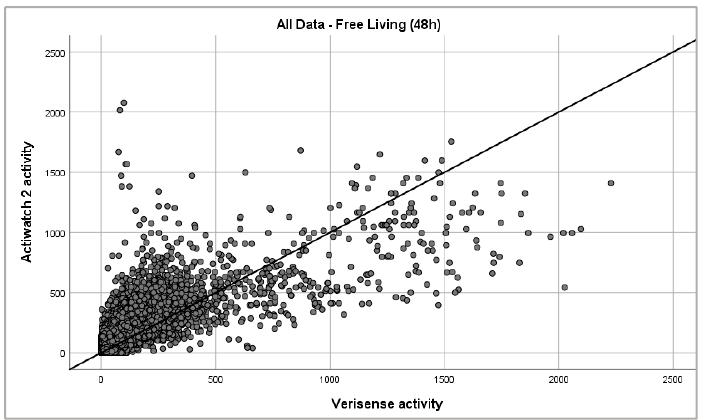
Figure 3. Epoch-by-epoch absolute activity of Actiwatch 2 and Verisense as recorded from all subjects over 48 h (163,759 data points).